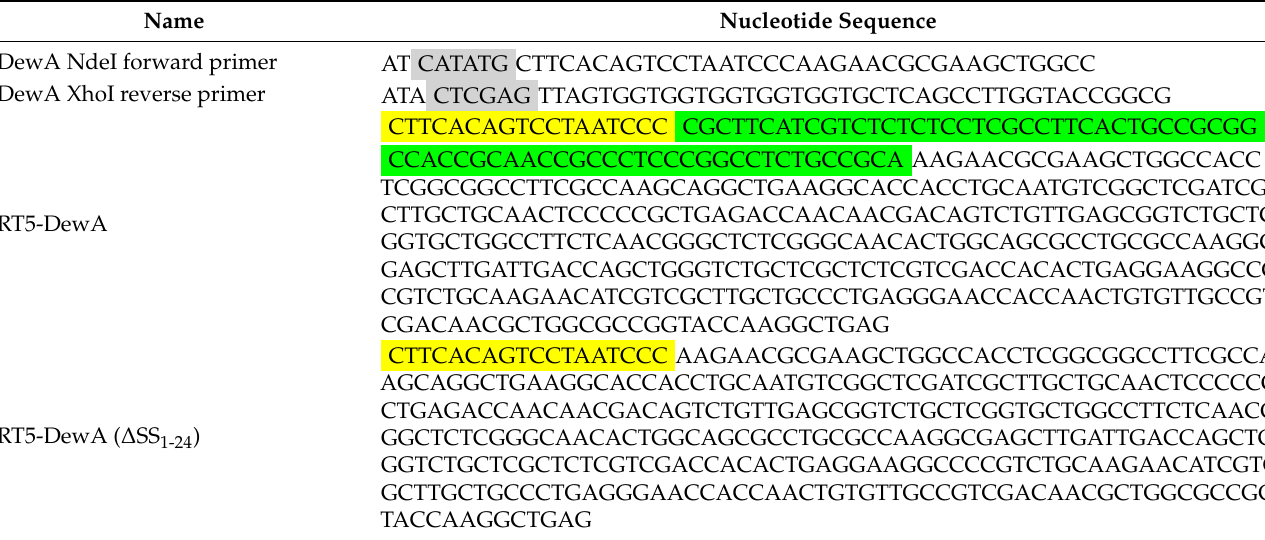
Table 2. Nucleotide sequences of primers and DewA with or without the signal